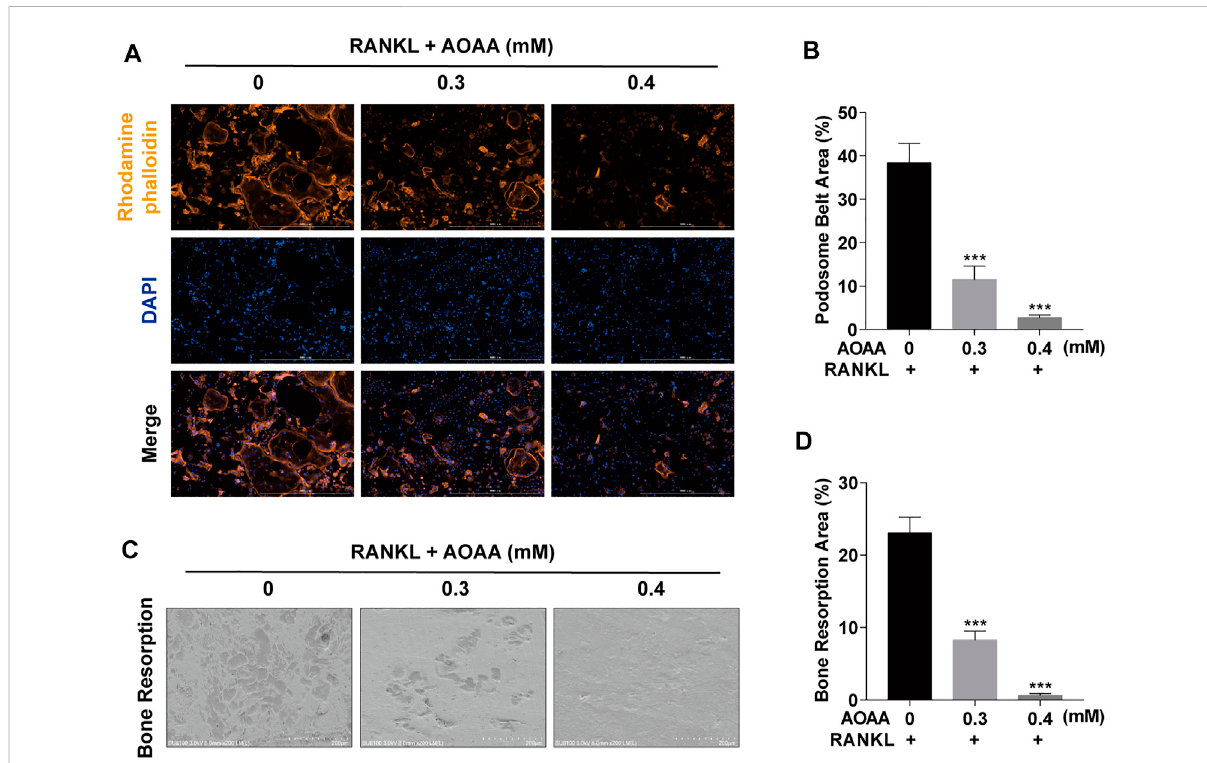
FIGURE 2 AOAAsuppressesosteoclastresorptionfunction invitro (A) Representativeimagesofpodosomebeltformation(orange,Rhodaminephalloidin) and nuclei (blue, DAPI) staining of osteoclasts (scale bar = 1000 µM). (B) Quanti fi cation of podosome belt area. (C) Representative images of osteoclastresorptionfunctiononboneslices(scalebar=200 µM). (D) Quanti fi cationofboneresorptionarea.Allexperimentaldataareexpressedas mean ± SD ( n = 3). ***p < 0.001 compared with that in the control group (AOAA, 0 mM). One-way ANOVA was